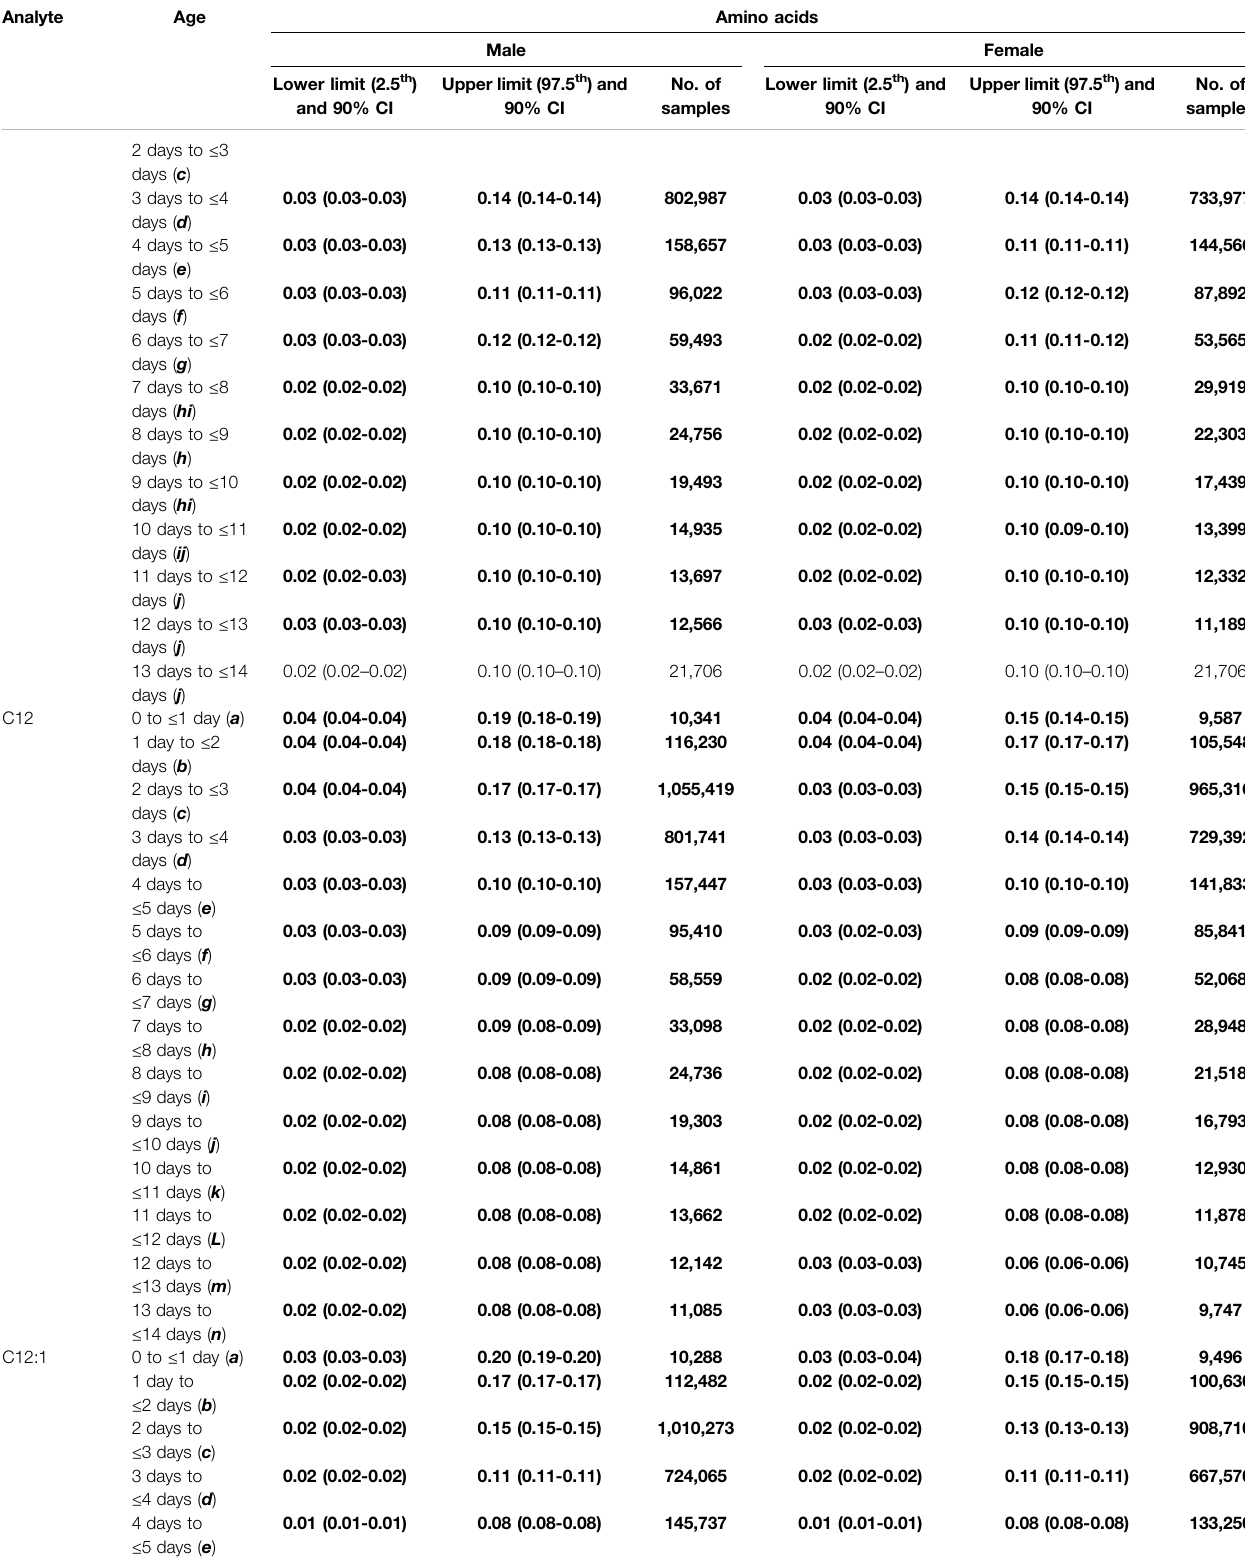
TABLE 2 | ( Continued ) The Reference intervals partitioned by each day and sex for 35 MS/MS NBS biomarkers ( μ